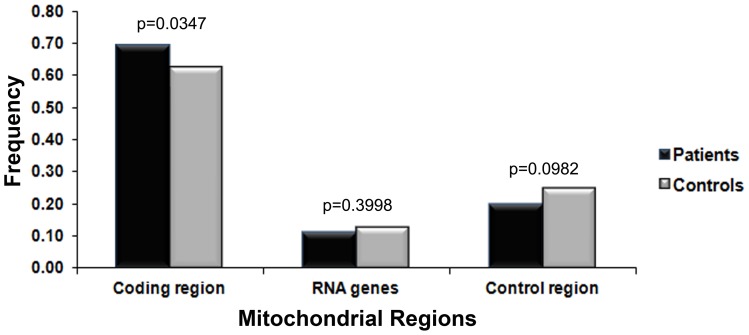
Distribution of segregating sites in different regions of mtDNA.The frequency of segregating sites was marginally higher for coding regions in the patients relative to the controls (0.69 vs 0.62, p = 0.0347). No significant difference was observed in the RNA and the control region.